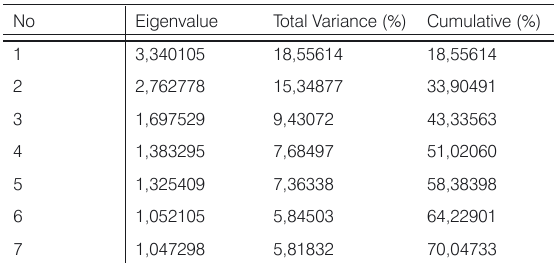
Table 4. Individual and cumulative eigenvalues of all healthy subjects studied biochemical parameters. parameters.No Eigenvalue Total Variance (%) Cumulative